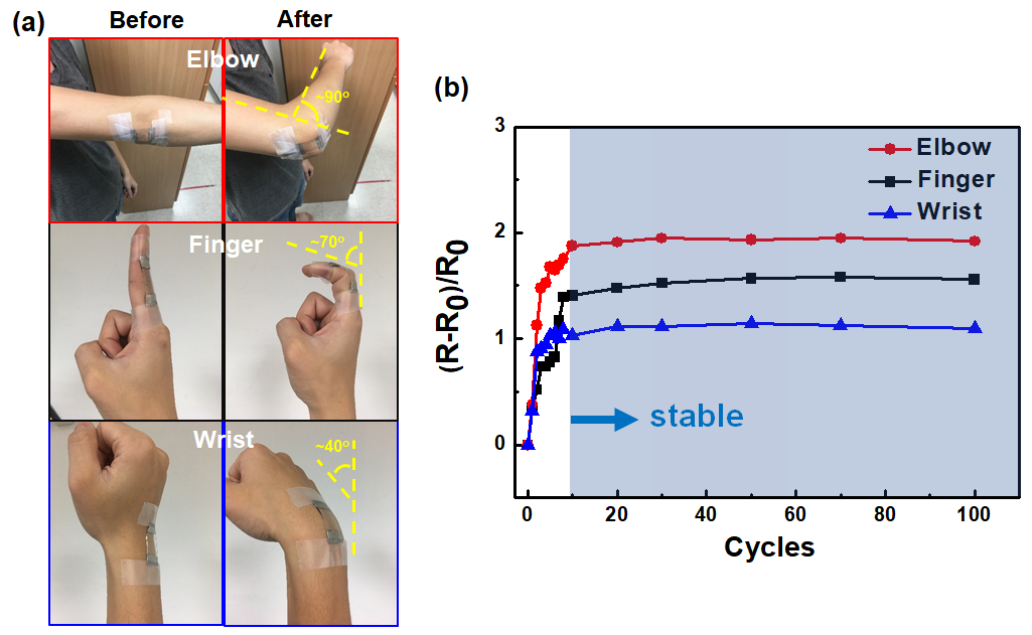
Figure 8. ( a ) Optical images of the sandwich structure placed on different parts of human body and ( b ) the corresponding variations of electrical resistance under stretching cycles.